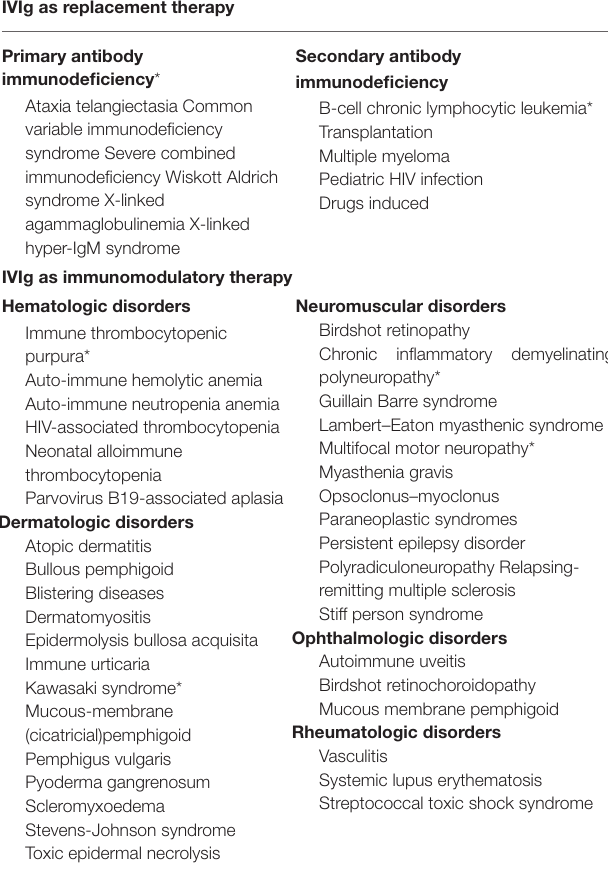
TABLE 1 | Major indications of IVIg